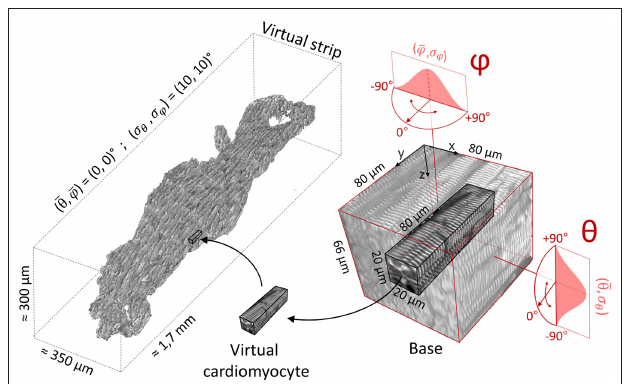
FIGURE 4 | Virtual sample generation. On the right, a representative 3D portion (base) of a Z-bands reconstruction previously aligned with Y axis. Virtual cardiomyocytes are extracted from the base and inserted in the silico sample (on the left). Base rotations are randomly selected from two normal σ ϕ ϕ distributions (here, ¯ θ 0 ◦ and σ θ 10 ◦ = = = ¯ =